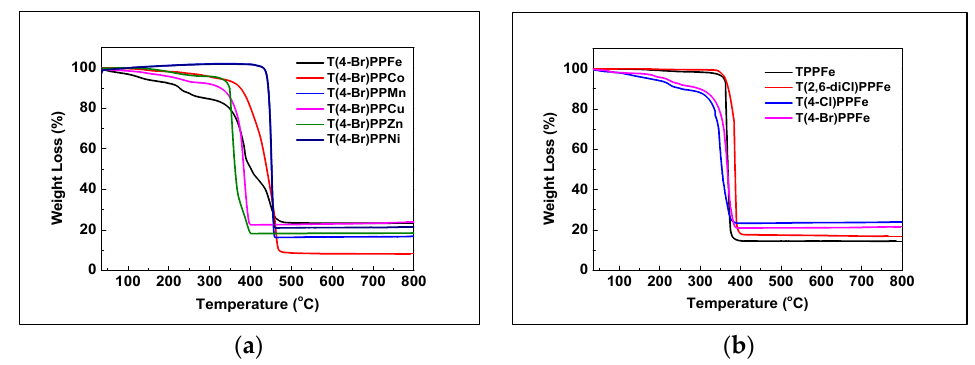
Figure 3. Thermogravimetric analysis of metalloporphyrins ( a , b ).